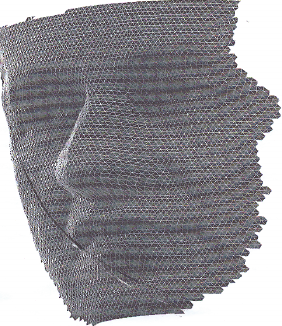
Fig. 1. Example of a “non-planar” image.